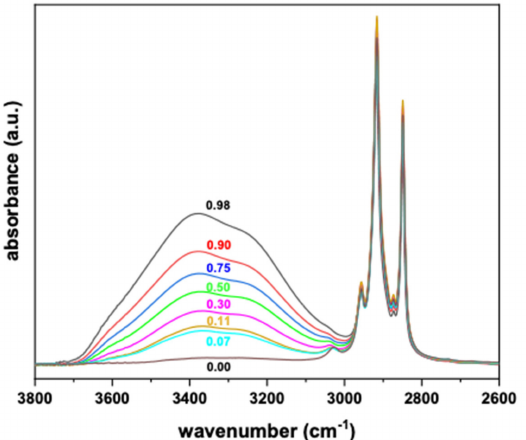
Figure 1. FTIR spectra of DPPC between 3800 and 2700 cm − 1 equilibrated at different water activities denoted by different colors at 25 ◦